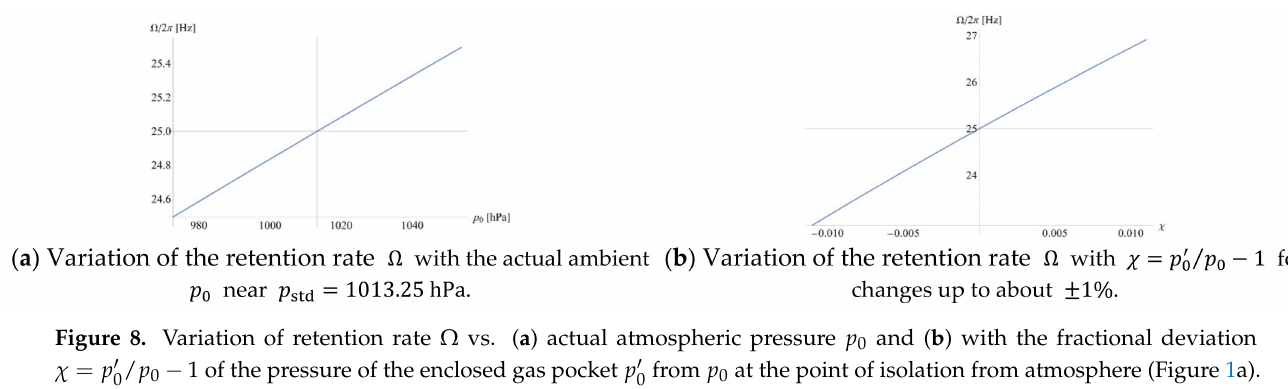
Figure 8. Variation of retention rate Ω vs. ( a ) actual atmospheric pressure p 0 and ( b ) with the fractional deviation χ = p (cid:48) / p 0 − 1 of the pressure of the enclosed gas pocket p (cid:48) from p 0 at the point of isolation from atmosphere (Figure 1a). 0 0 Note that variations in χ of more than a few permille have a considerable impact on Ω (5), (6) and (16). The dotted lines indicate the standard deviations ∆Ω obtained at p 0 = p std ( a ) and for χ = 0, ( b ) using the standard parameter values (see Appendix